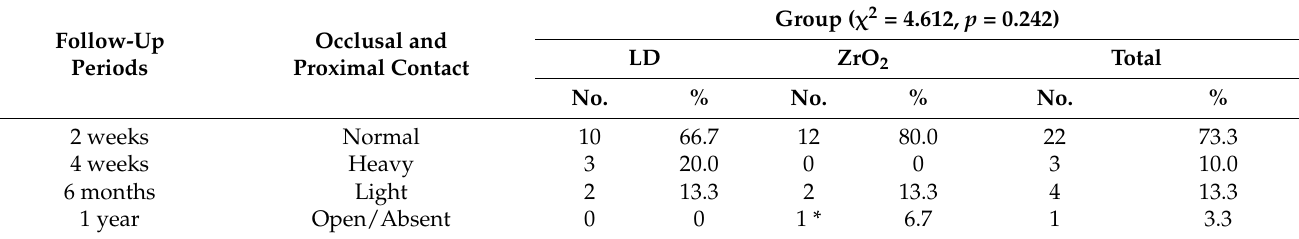
Table 5. Occlusal and proximal contact in study groups.